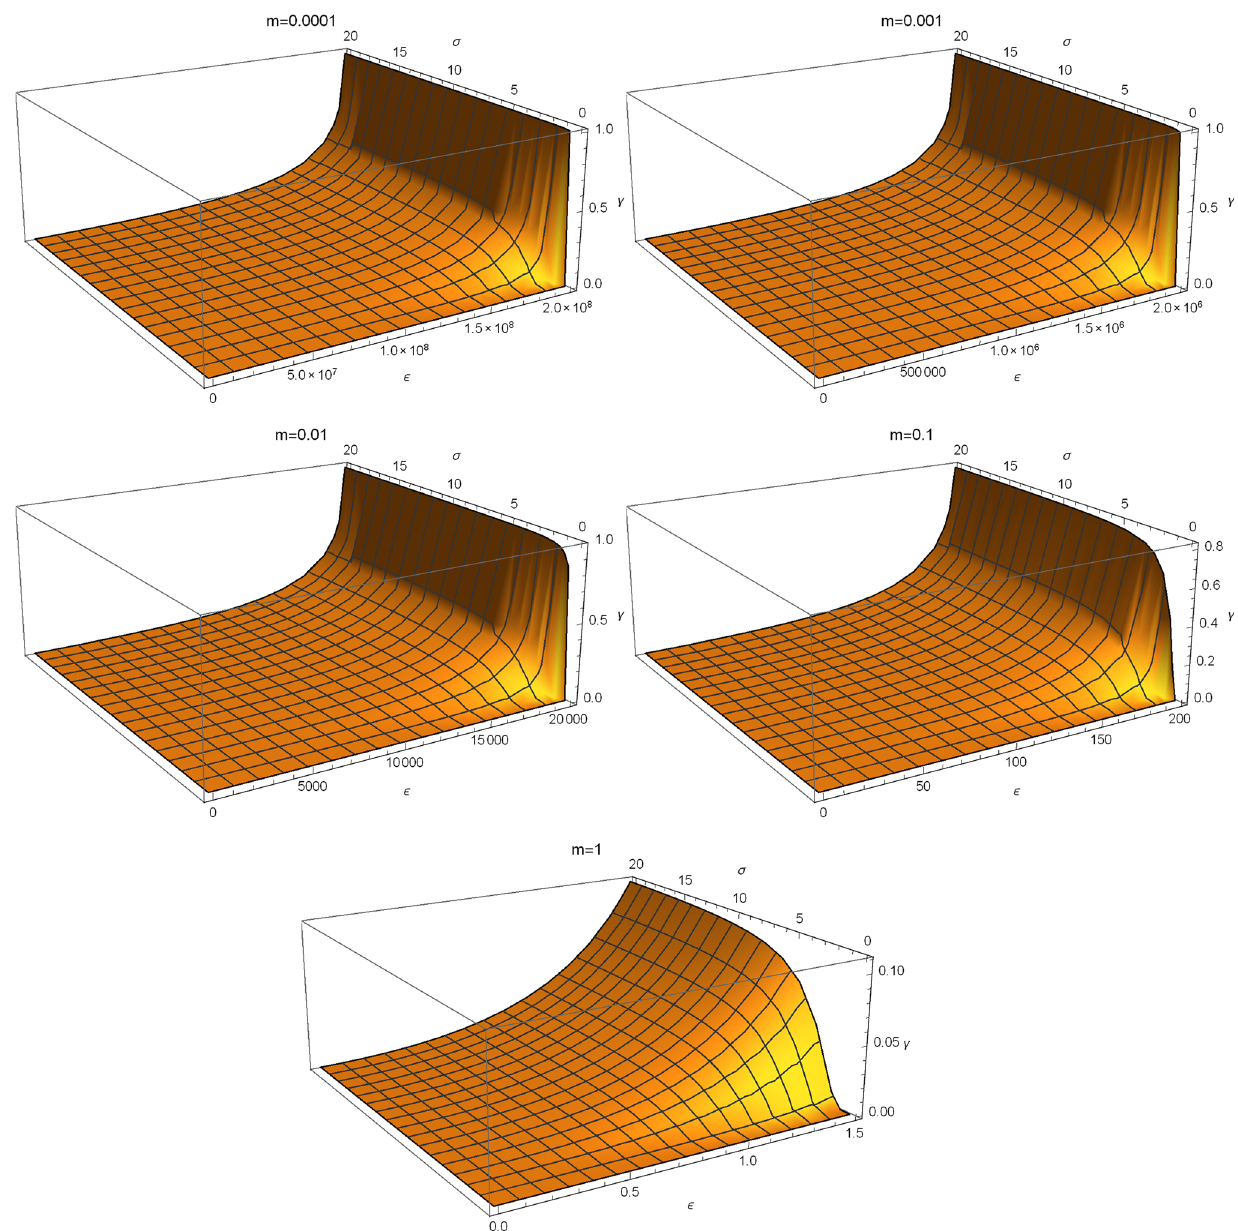
Fig. 13 γ as a function of the volume ε and the rapidity σ of the cos- mic expansion, for m = 0 . 0001 , 0 . 001 , 0 . 01 , 0 . 1 , 1, respectively. The parameters of the two originally entangled qubits A and B are the